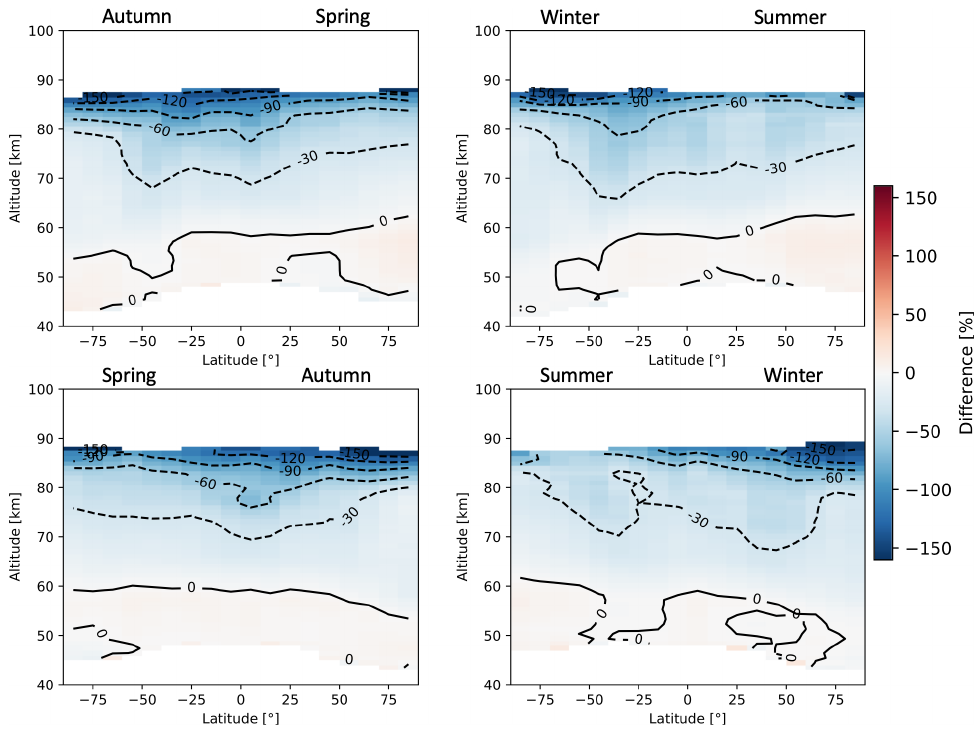
Figure A19. Seasonal zonal means of H 2 O FM19 SMR–MLS relative differences averaged over the time period between July 2004 and April 2019. The seasons are intended as astronomical seasons, i.e. each starting at the respective solstice or equinox.